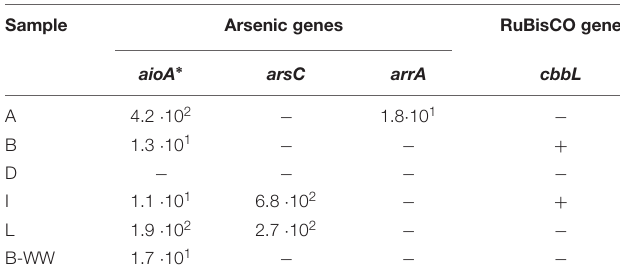
TABLE 2 | Biomarkers quantification (gene copies per L) of arsenic cycle genes and for chemoautotrophy in groundwater